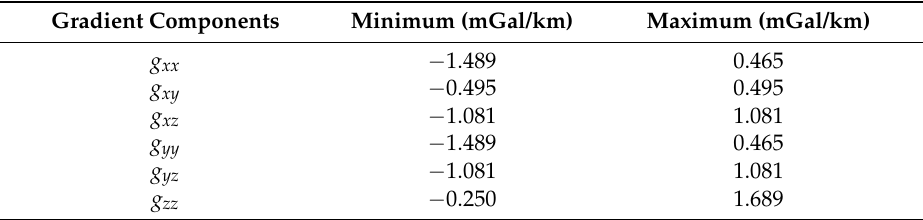
Table 1. The value of the gravity gradient tensor based on rectangular prism